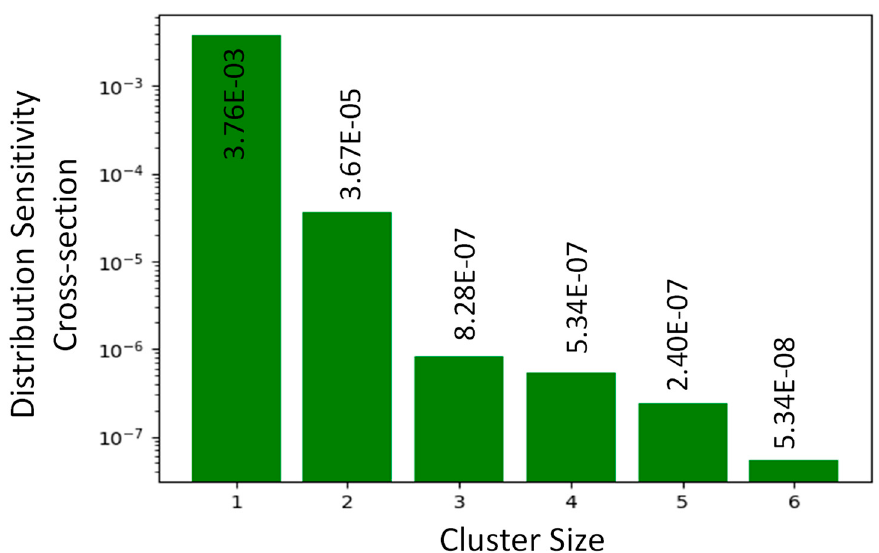
Figure 2. Cluster distribution cross-section for different cluster sizes.